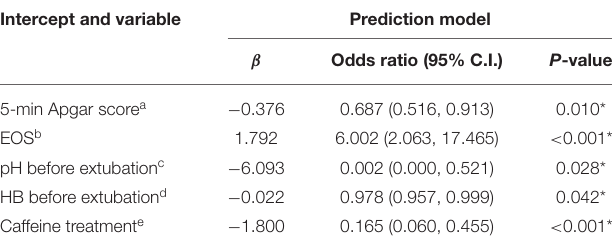
TABLE 2 | Prediction factors for extubation failure in MVEI